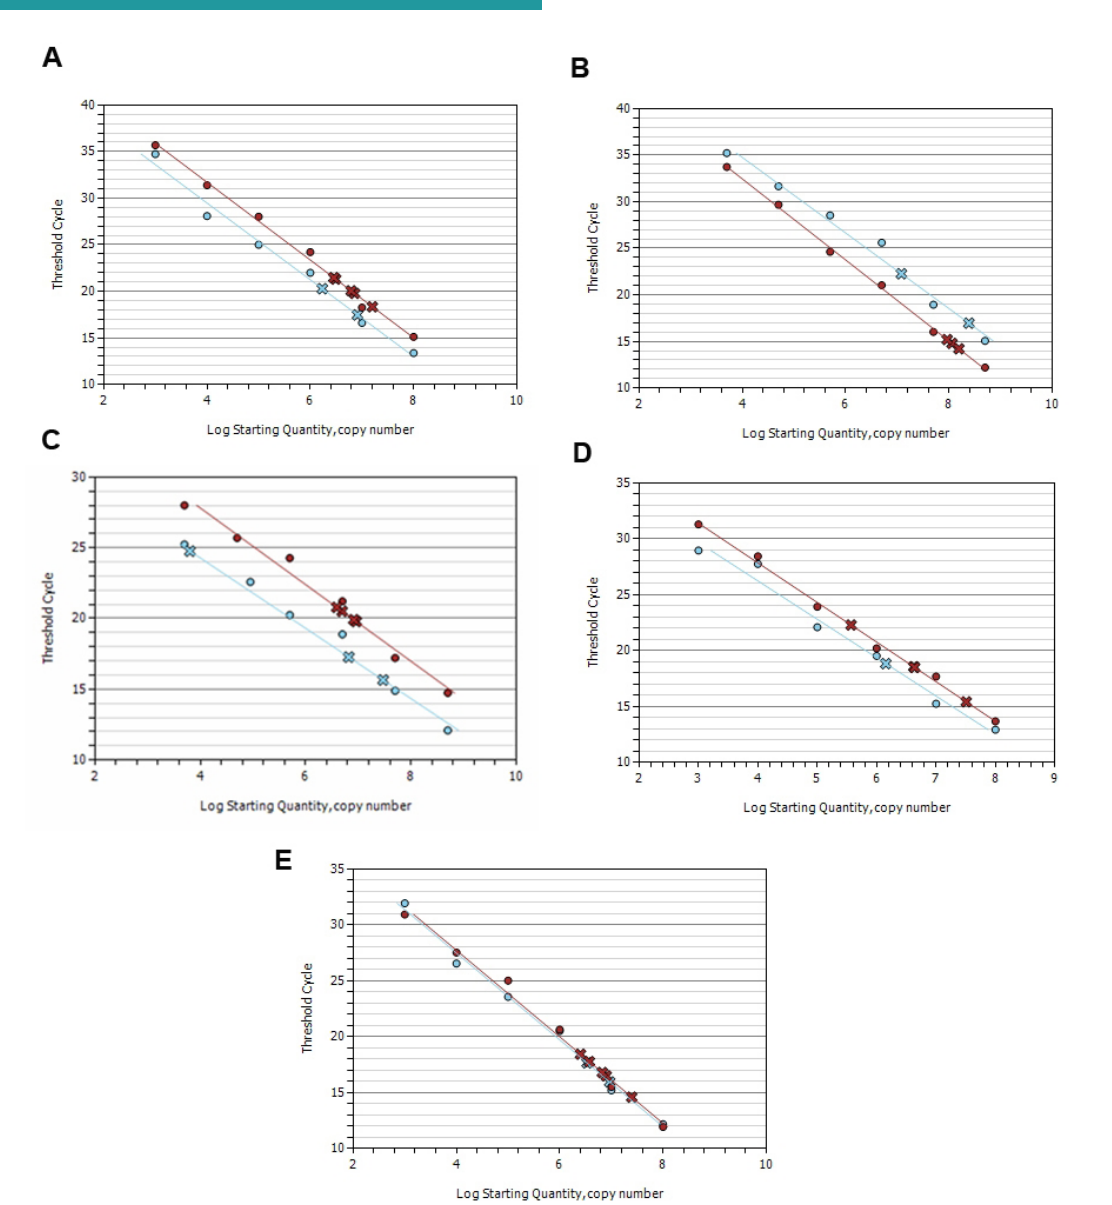
Figure 4. Taqman LNA-probe real-time PCR for quantitative measurement of A3243G heteroplasmy level in real samples. Standard curves of FAM (sky blue lines) and HEX (magenta lines) signals showing relation between threshold cycles and copy number of mutants and wild types, respectively, based on six standards and compared to real samples of five patients and their family members. (A) Family 1: R FAM2 = 0.990; R HEX2 = 0.985. (B) Family 2: R FAM2 = 0.985; R HEX2 = 0.998. (C) Family 3: R FAM2 = 0.980; R HEX2 = 0.985. (D) Family 4: R FAM2 = 0.981; R HEX2 = 0.995. (E) Family 5: R FAM2 = 0.991; R HEX2 =